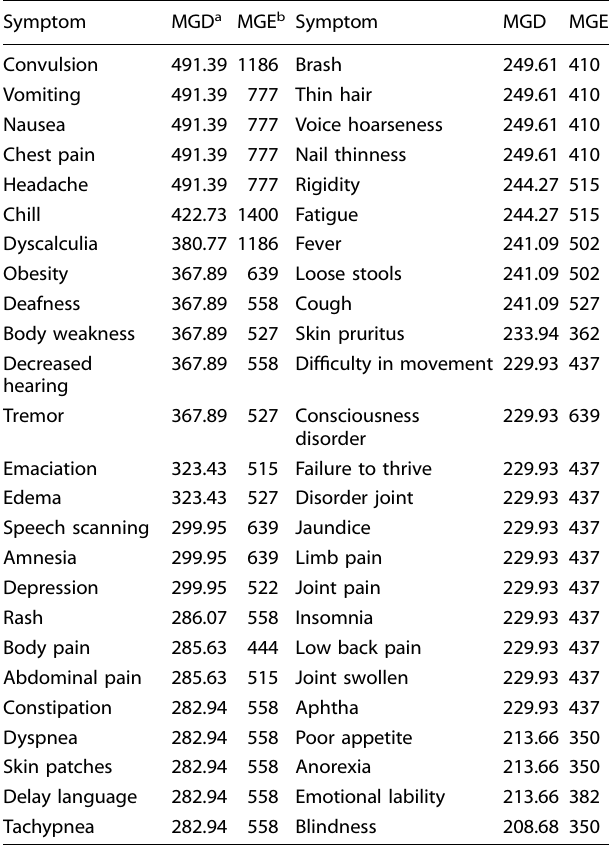
Table 2. Quantifying the molecular network diversity of symptom phenotype in SCN (including the top 50 symptoms sorted by the molecular network diversity in